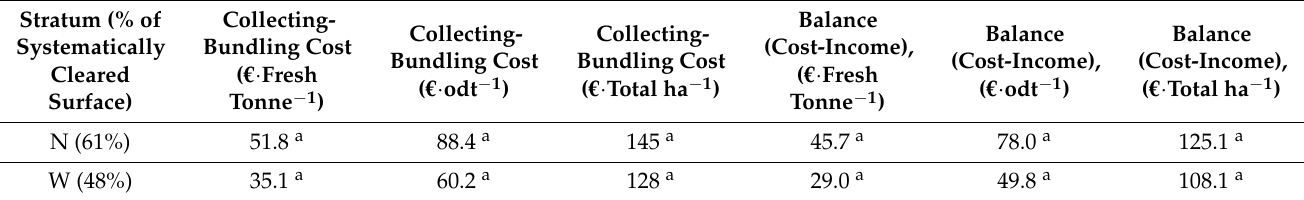
Table 5. Biobaler collecting and bundling unit cost and balance (including clearing, baling, forwarding, biomass transport and income from biomass sale) per tonne and total surface (ha). Acronyms: N, narrow; W, wide; odt, oven dry tonne; ha, hectare (the different superscript letters indicate statistically significant differences at 95% probability).